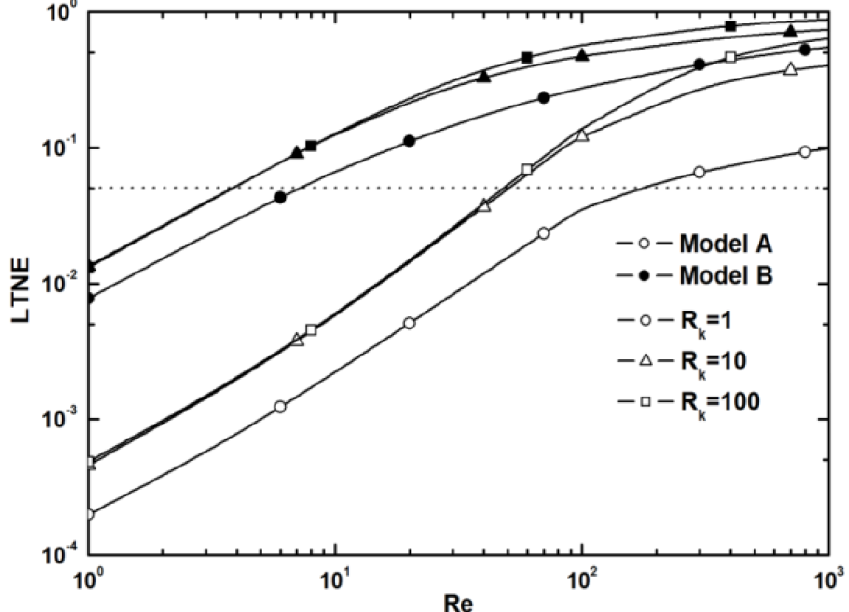
Figure 27. Profiles of LTNE parameter with Reynolds number, for various solid/fluid thermal conductivity ratio, presented by Abdedou and Bouhadef [51].